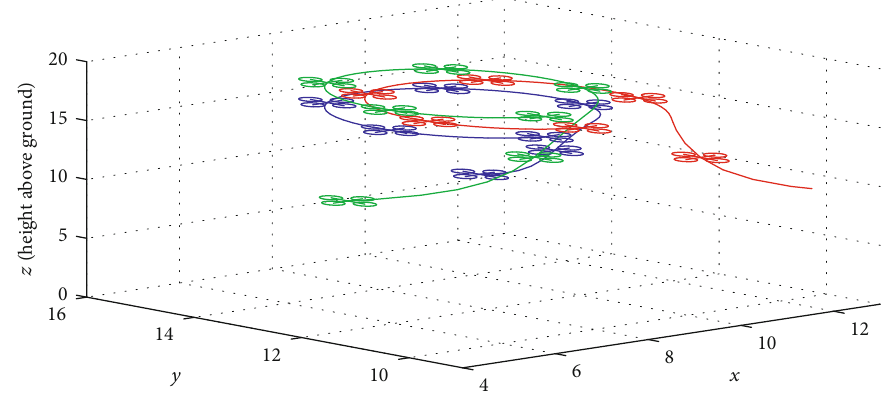
Figure 5: 3D position trajectory of the three